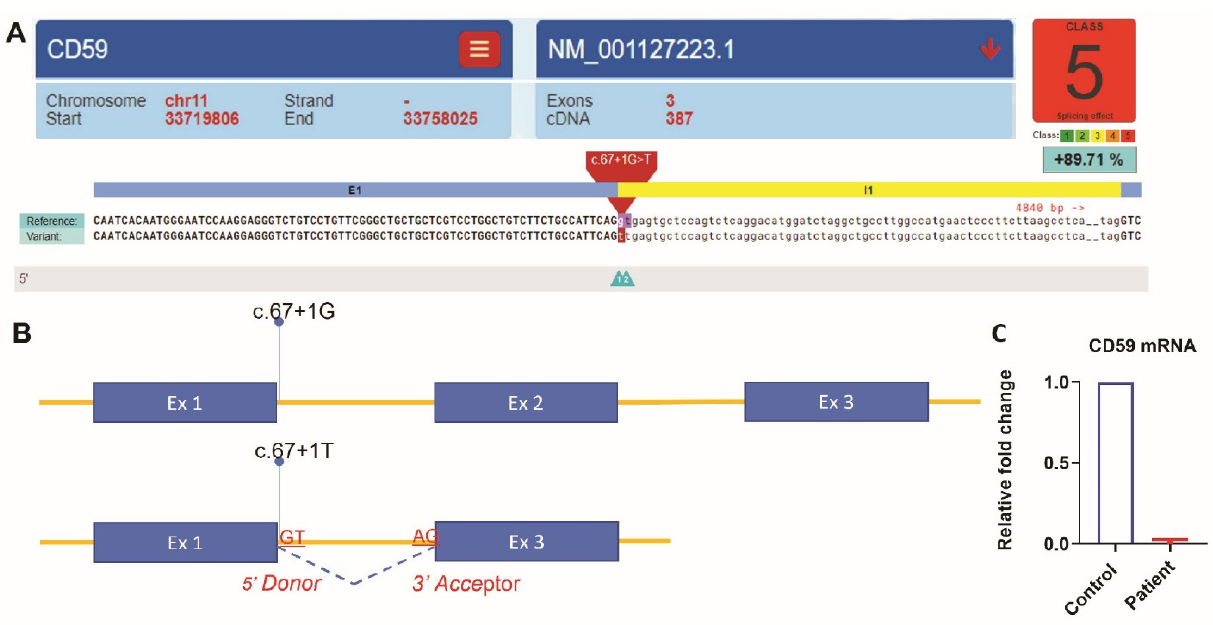
Figure 1. NGS analysis identified a homozygous splice site mutation c.67 + 1G > T in intron 1 of the